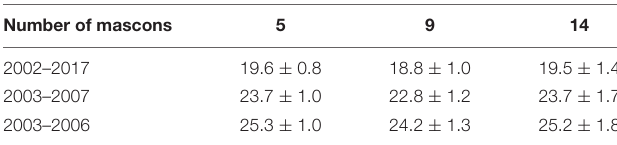
TABLE 7 | Mean mass losses in Gt/year considering three different time-periods over a spatial subset corresponding to mascons 6, 7, and 10 in Luthcke et al. (2008; see Figure 7A ), which correspond to the Saint Elias Mountains.